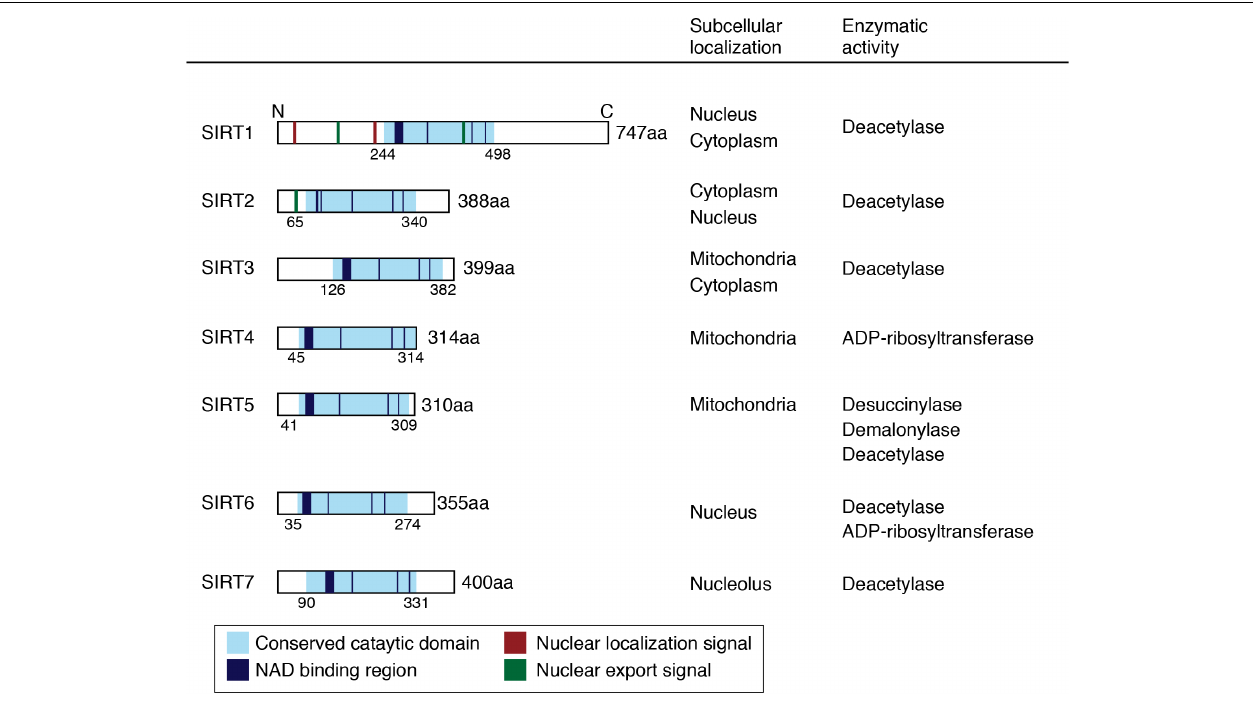
FIGURE 1 | Schematic images and biological activities of human sirtuins. Conserved catalytic domains, NAD binding regions, nuclear localization signals, and nuclear export signals are shown in the